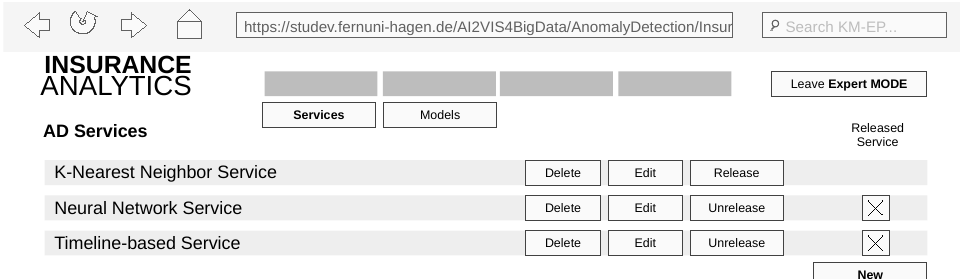
Figure 12. Service-centric expert user view extended with a view on AI and ML